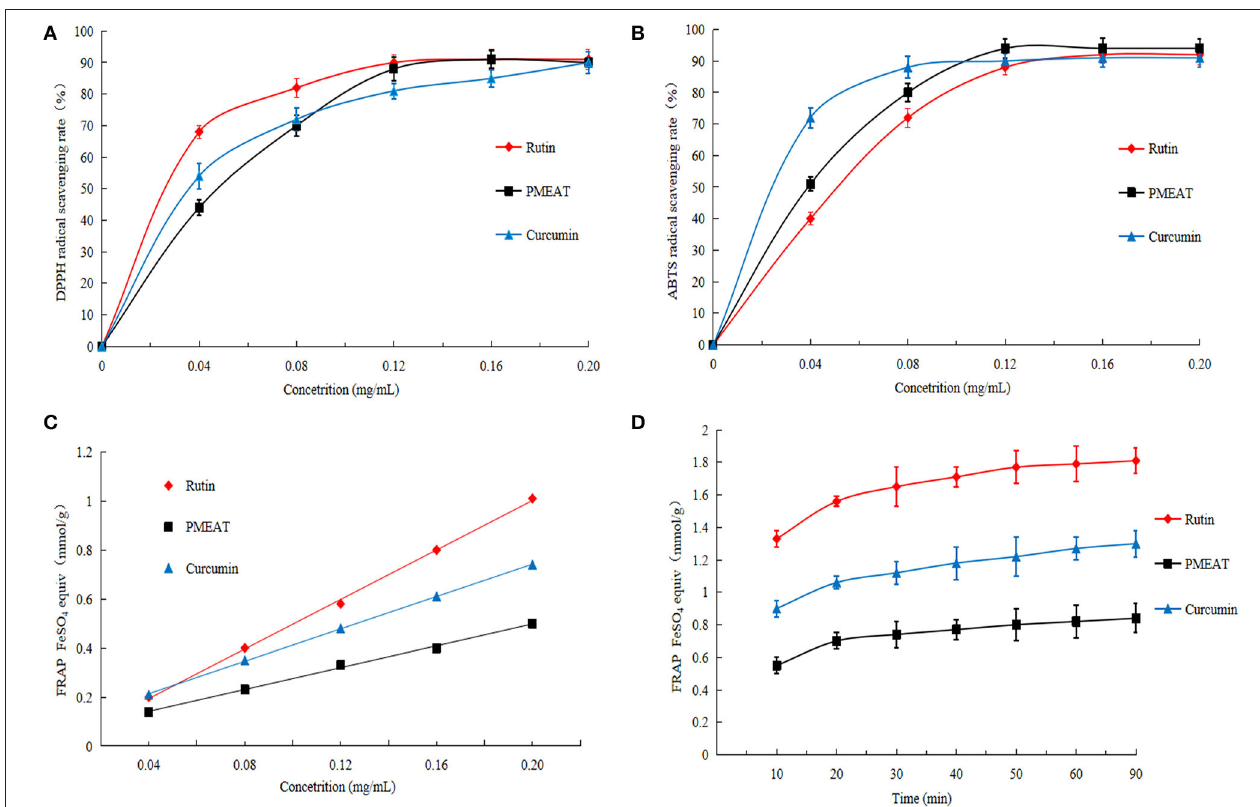
FIGURE 4 | The in vitro antioxidant activity of PMEAT. (A) DPPH scavenging effect of rutin, PMEAT, and curcumin. (B) ABTS scavenging effect of rutin, PMEAT, and curcumin. (C) Result of FRAP assay of rutin, PMEAT, and curcumin. (D) FRAP time-dependent curve of rutin, PMEAT, and